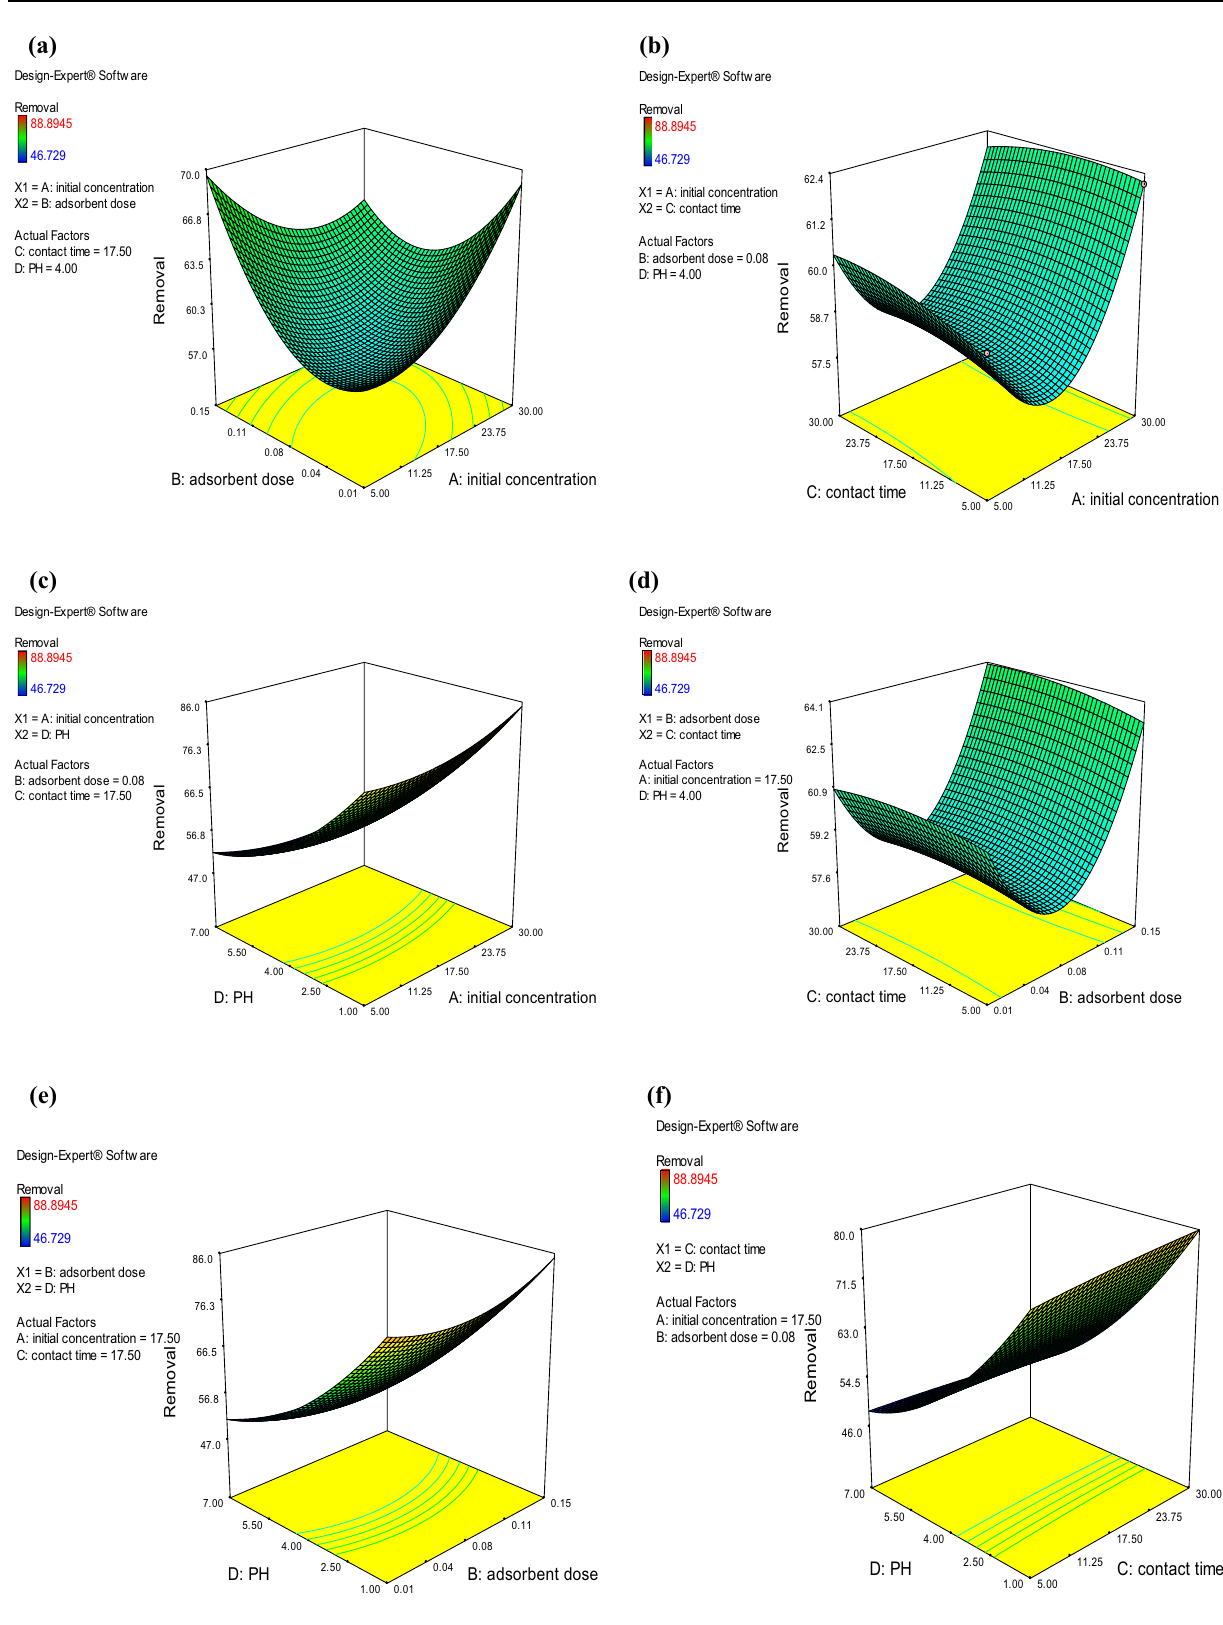
Fig. 11 a – f Response surface plots showing the effect of independent variables on Cr(VI) adsorption onto chicken